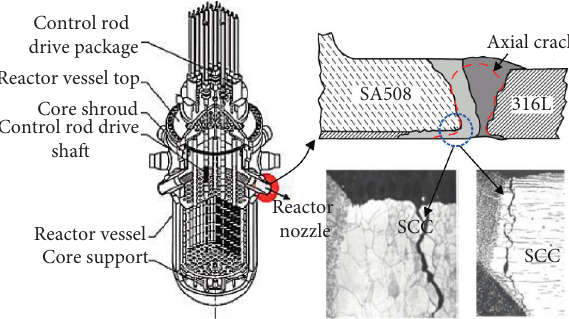
Figure 1: Schematic diagram of stress corrosion cracking of welded joint at the safety end of the primary circuit of PWRs [9, 10].